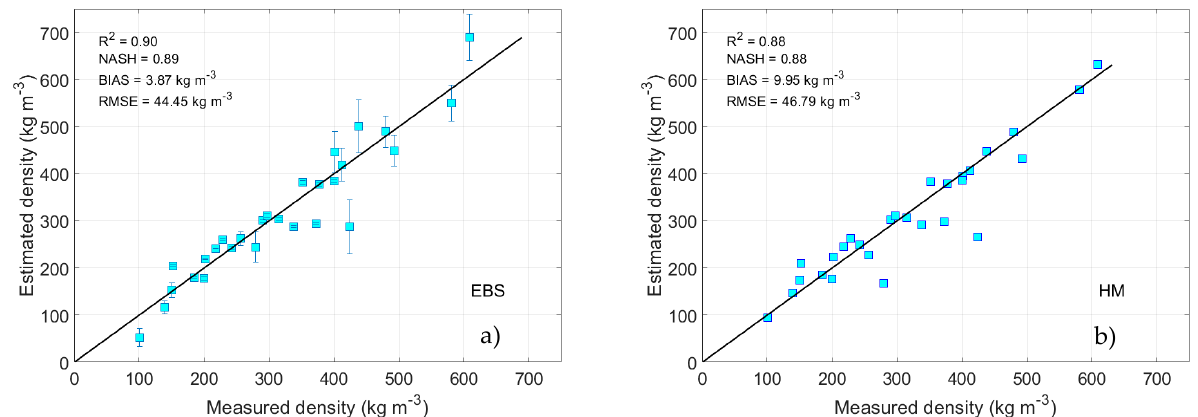
Figure 7. Snow density estimated by the two models ( a ) EBS and ( b ) HM compared to the in situ measurements for the independent database.